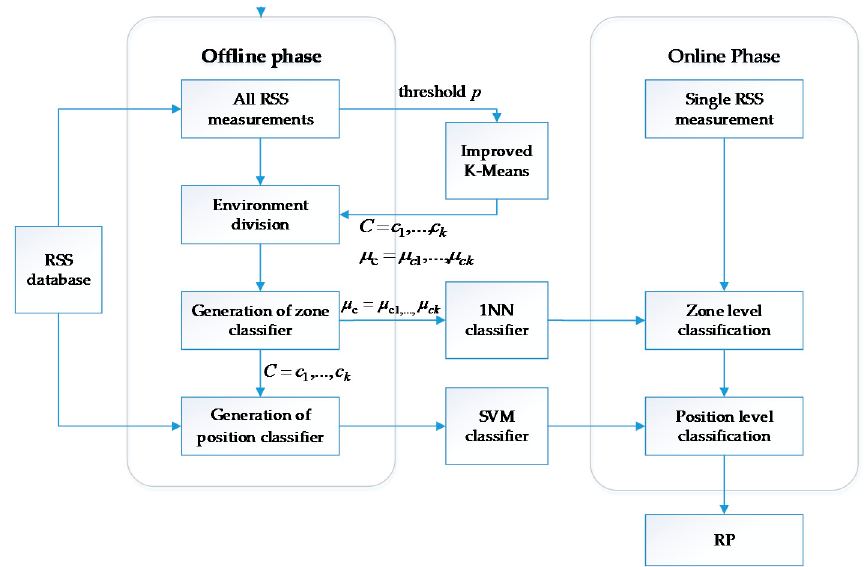
Figure 3. Proposed hierarchical indoor localization system.